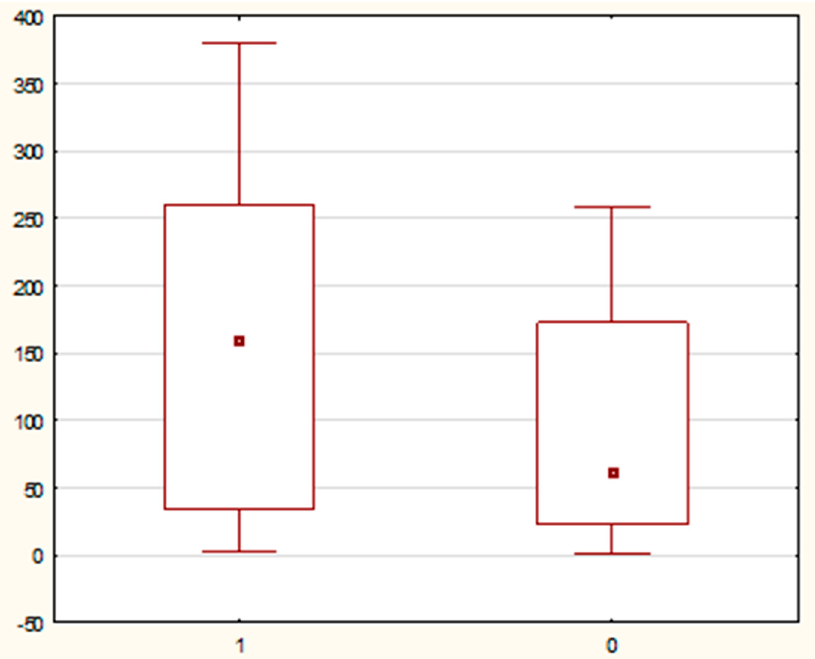
Figure 5. A box-whisker plot showing a comparison of MMP-8 ng/mL concentrations (assessed in cervical samples) in the study-1 and control-0 groups.